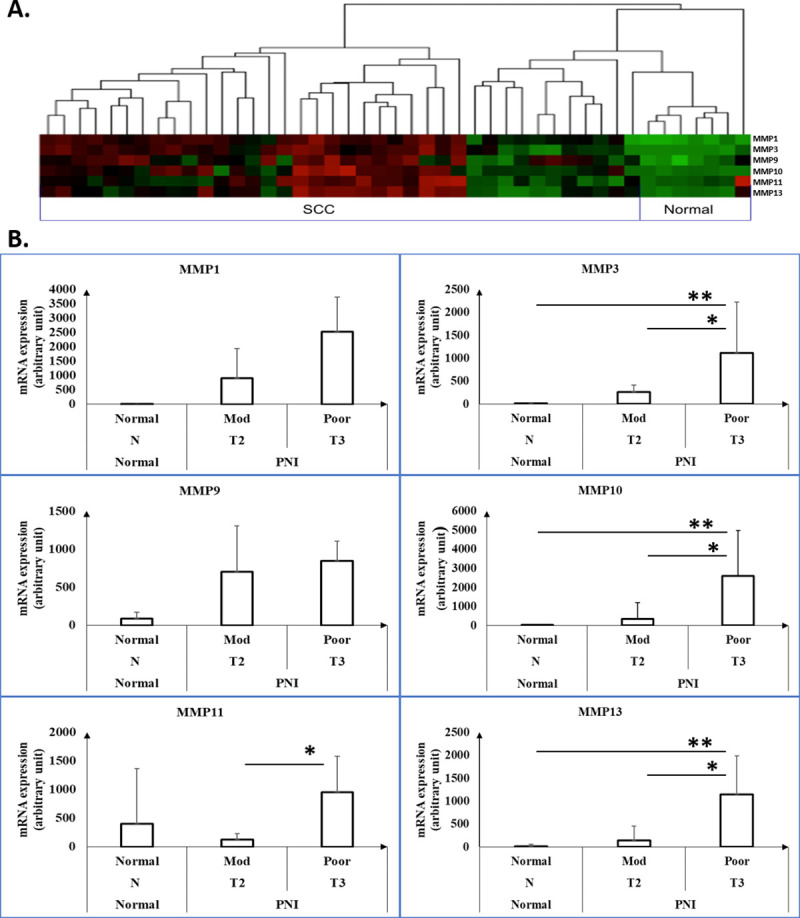
Expression of MMPs in normal skin and cSCC tumors with PNI based on BWH tumor stage and tumor differentiation.(A) The nSolver’s Heat Map Cluster Analysis of normalized MMP1, 3, 9, 10, 11 and 13 in all samples. (B) Comparison of mRNA expression of MMPs in the three groups, as noted on the x-axis, based on BWH tumor stage and tumor differentiation. Mod = moderate differentiation; Poor = poor differentiation; N = normal; T2, T3 = BWH tumor stage. * and ** represent p<0.05. MMP3, 10, 11 and 13 expression were significantly increased in poorly differentiated cSCC with PNI compared with moderately differentiated cSCC with PNI. However, MMP 11 levels were not different compared with poorly differentiated cSCC with PNI and normal skin tissues (p = 0.325).